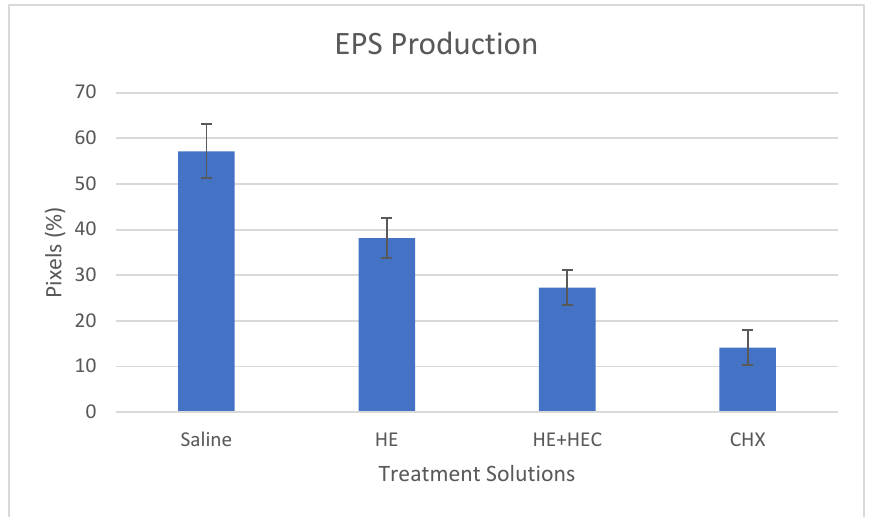
Figure 5. Effect of the various treatment solutions on Streptococcus mutans EPS production: saline as negative control; herbal extracts (HE); combined herbal extracts and hydroxyethyl cellulose (HE + HEC); and chlorhexidine (CHX) as positive control. Results (± standard deviation) are presented as percentage of maroon-stained pixels measured from digitally analyzed (Image J, NIH) fluorescent microscopy images.